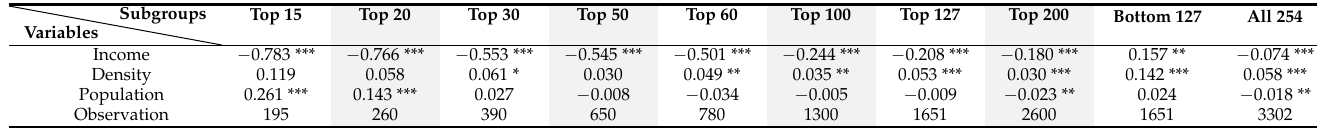
Table 7. Robustness tests of income, density, and population coefficients with four additional subgroups. Subgroups Top 15 Top 20 Top 30 Top 50 Top 60 Top 100 Top 200 Bottom 127 Variables Income